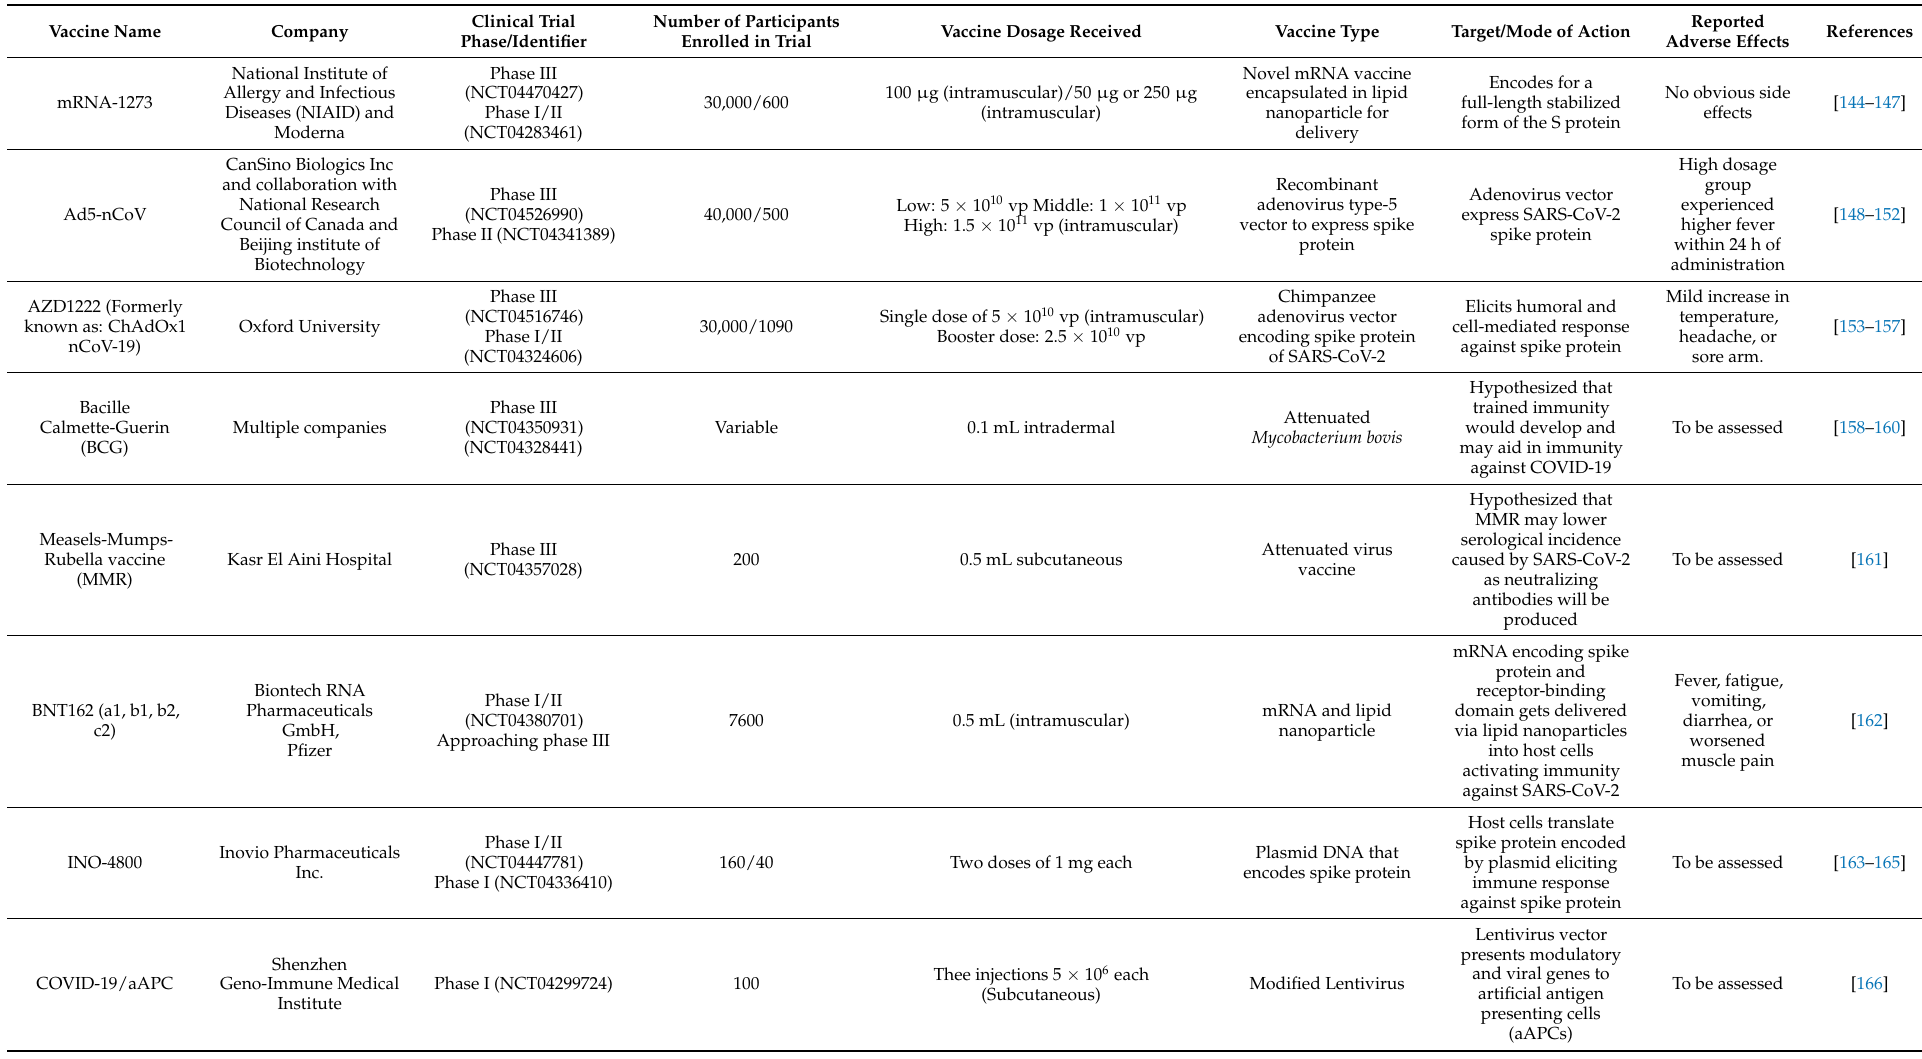
Table 5. Vaccine candidates undergoing clinical trial testing and their characteristics (updated as of